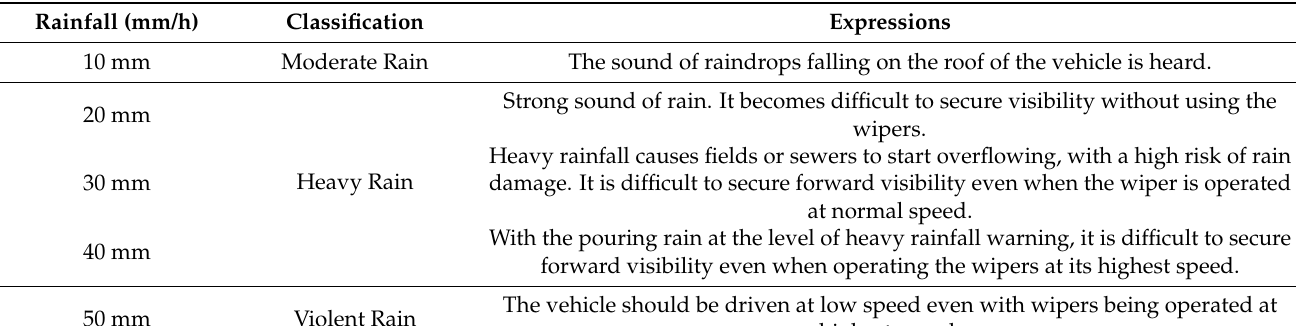
Table 5. Types of rainfall [26] used in the